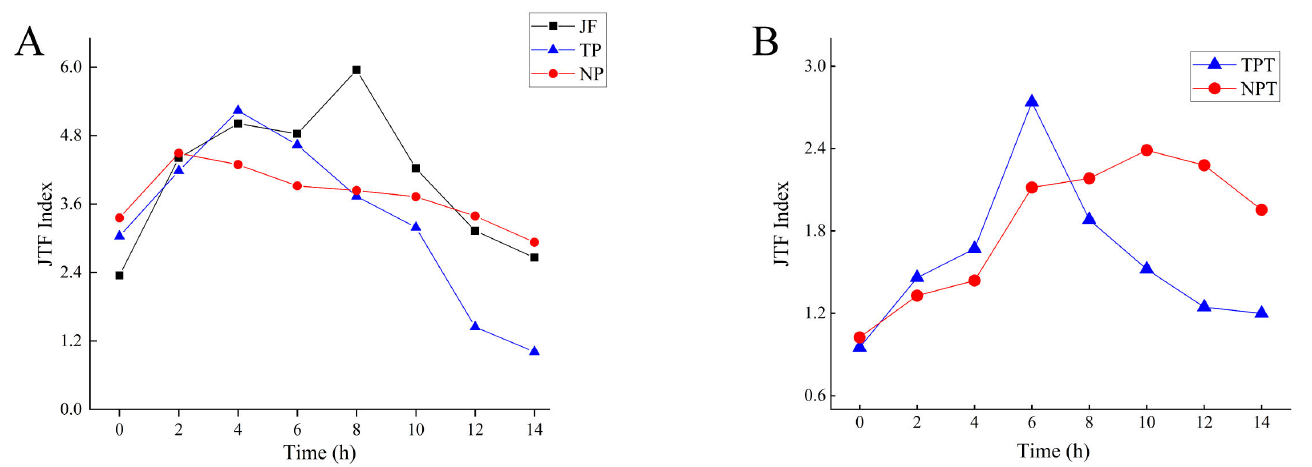
Figure 2. Changes in JTF index. ( A ) JTF of jasmine. ( B ) JTF of jasmine